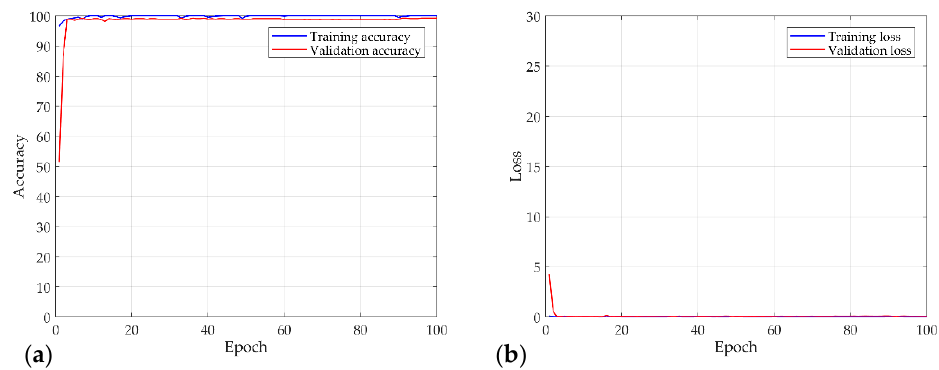
Figure 9. Results of the numerical experiment for the Rossler model: ( a ) accuracy; ( b ) and loss curves over 100 epochs.